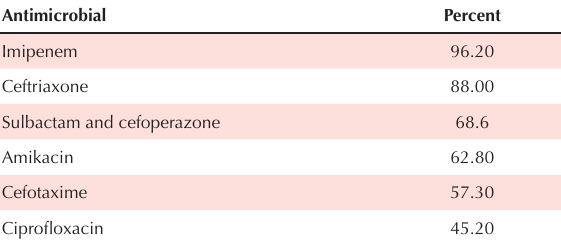
Table 4. Antimicrobial susceptibility of micro-organism isolated in peritoneal fluid Antimicrobial